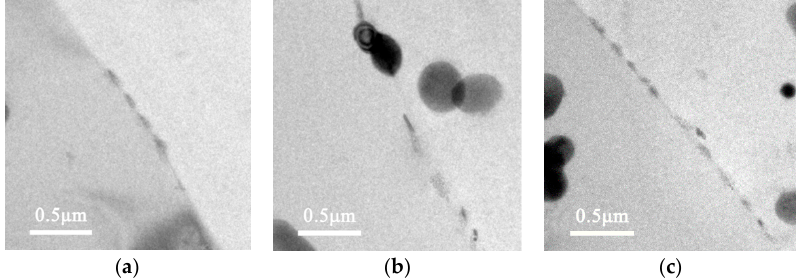
Figure 5. TEM images showing the distributions of grain boundary particles in ( a ) alloy A, ( b ) alloy B, and ( c ) alloy C.